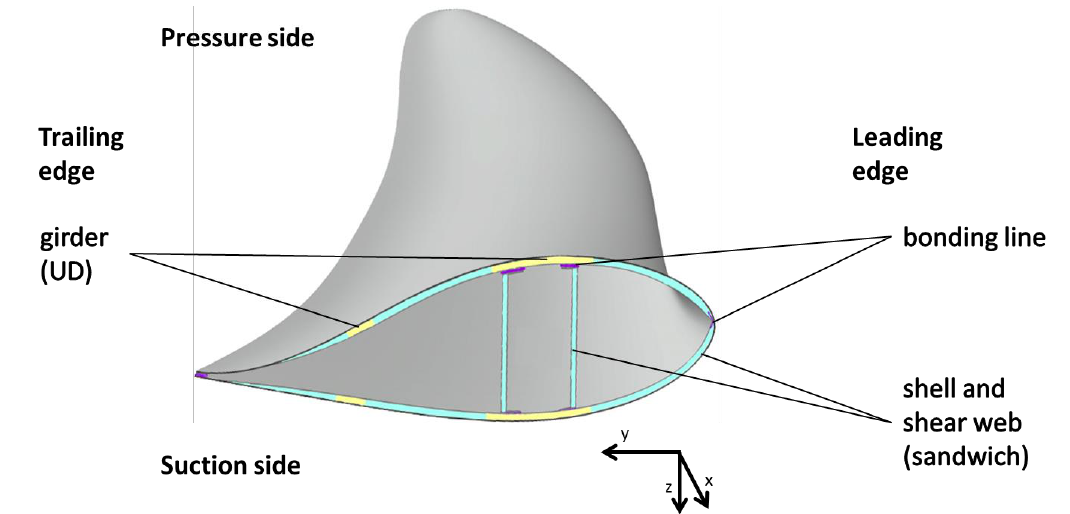
Figure 1. Typical cross section of a rotor blade according to [1–3].